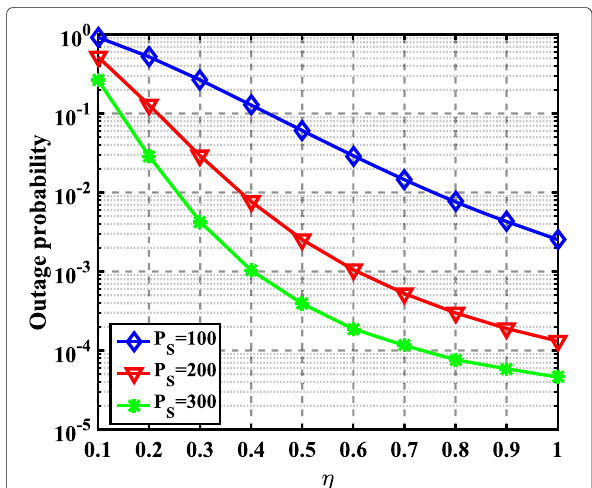
Fig. 10 Outage probability vs. η for trusted SUs with various P S